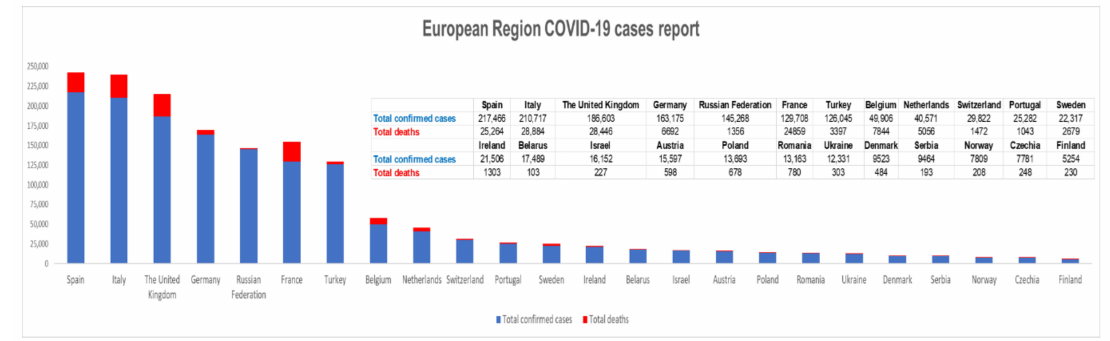
Figure 1. The European Region coronavirus disease (COVID-19) cases situation reported on 4 May 2020 according to World Health Organization (WHO) reports (in the graphic are presented only the countries with more than 5000 cases at that date)